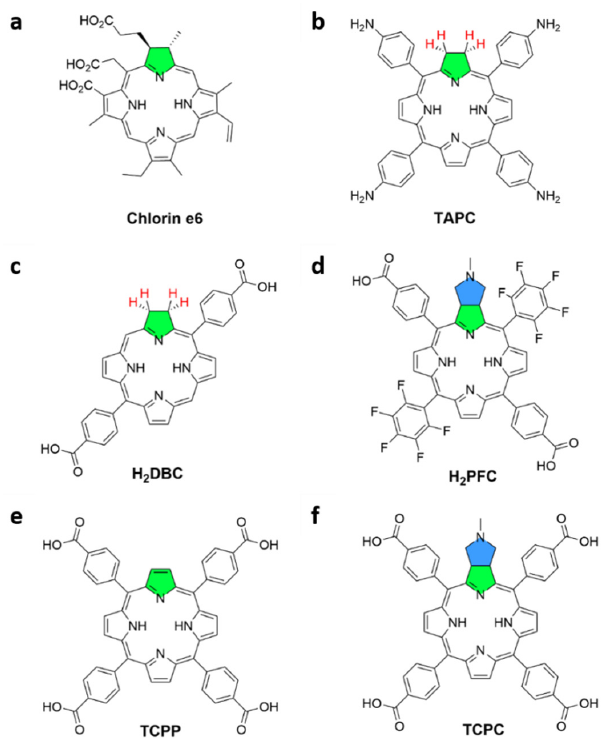
Figure 1. Structures ( a – d ) are some examples of porphyrins and chlorins previously reported for